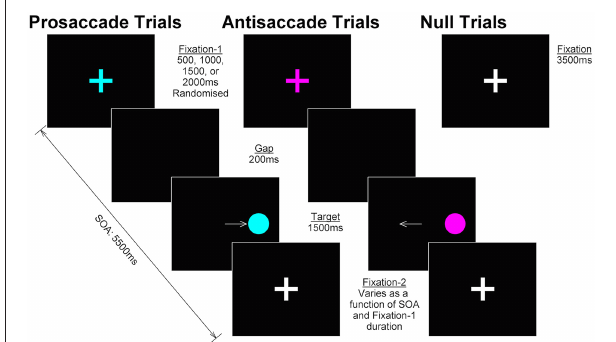
FIGURE 2 | Trial design. In prosaccade and antisaccade trials, a colored fixation cross (“fixation-1”) was presented for 500, 1000, 1500, or 2000ms, randomized between trials; color cued the identity of the currently relevant task and was counterbalanced across participants. Following a 200ms gap, the target appeared in either the left or right hemisphere (duration 1500ms); participants were required to make a prosaccade or antisaccade and hold their gaze in that position until the target was removed. The target was replaced by a white fixation cross (“fixation-2”) for the remainder of the SOA (5500ms—fixation-1 duration—target duration). Null trials consisted of a white fixation cross (duration 3500ms) visually indistinguishable from fixation-2 in prosaccade and antisaccade